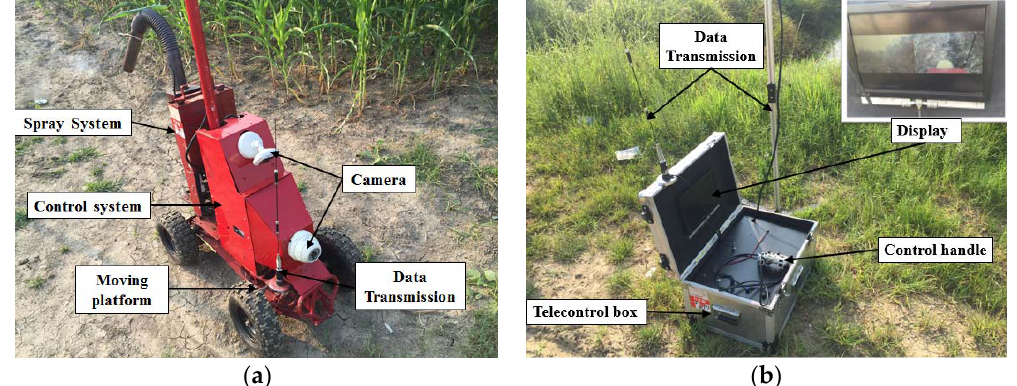
Figure 1. The system of the moving vehicle. ( a ) The moving and spraying execution system; and ( b ) the control platform.